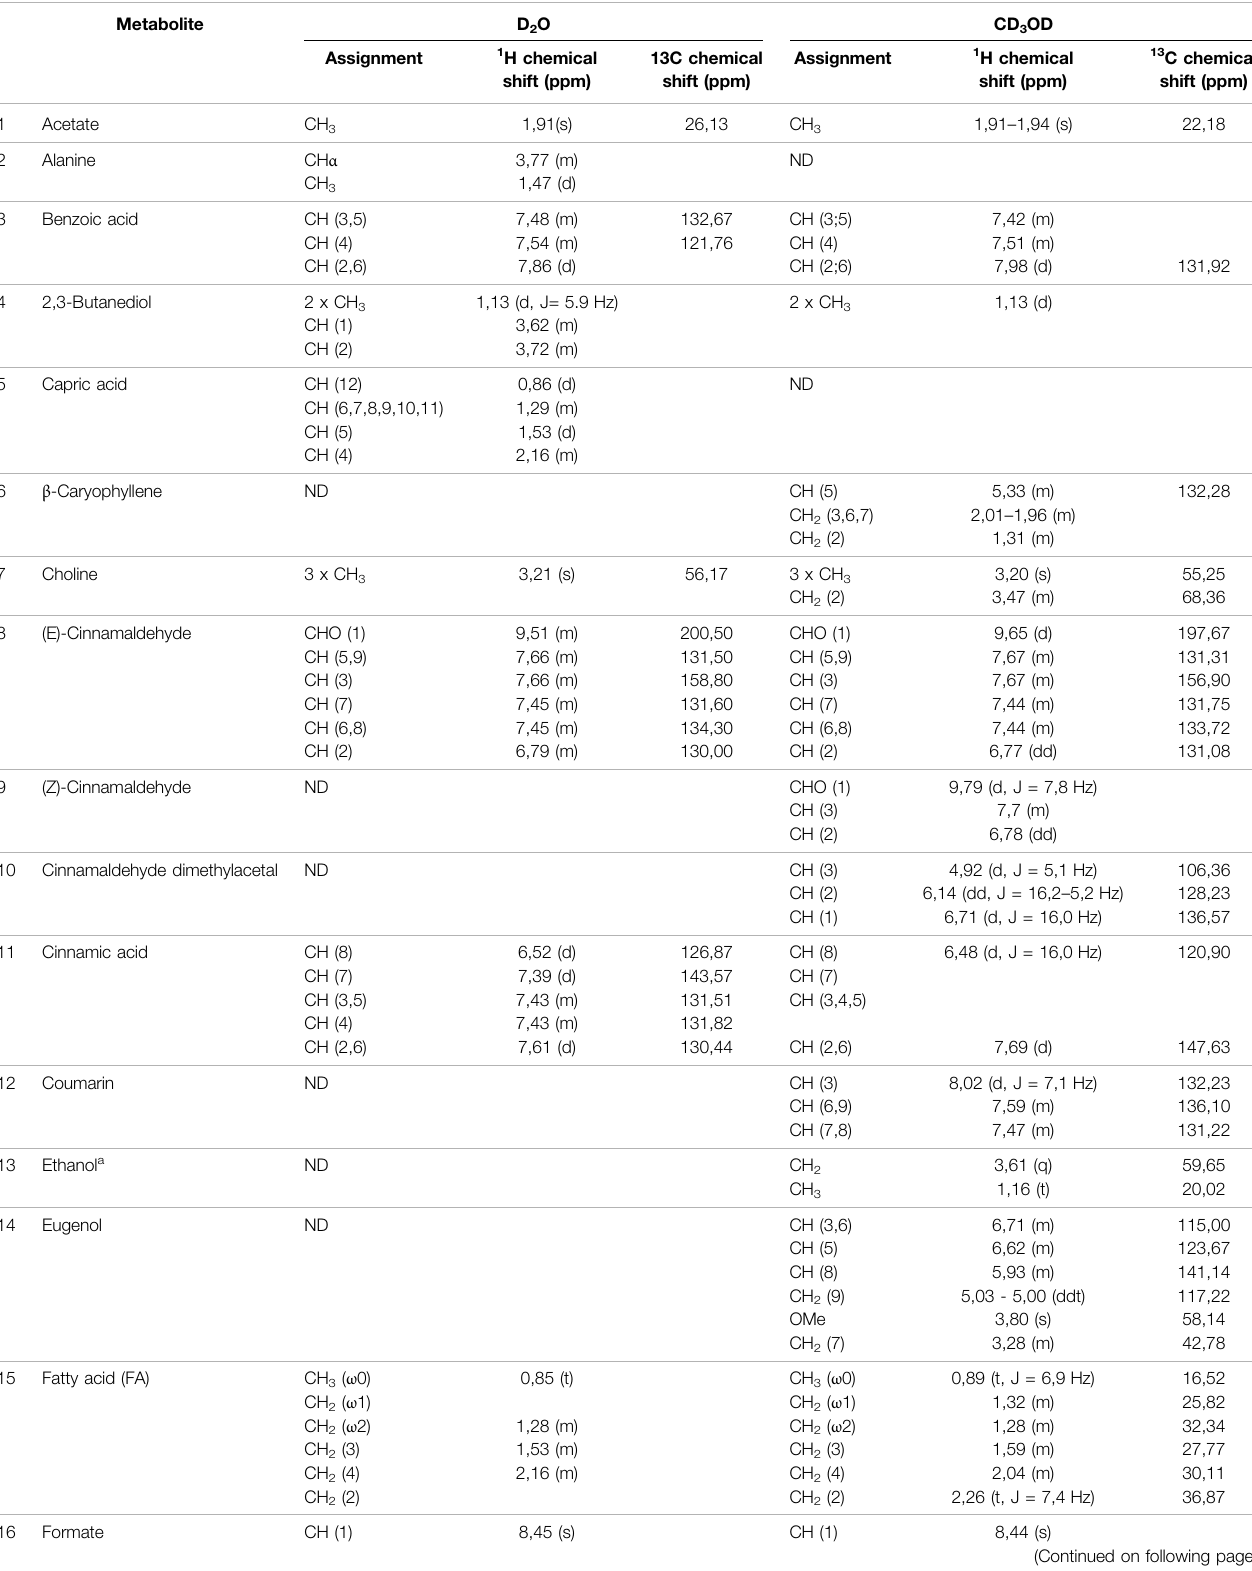
TABLE 1 | Assignments of 1 H and13C chemical shifts of the resonances of metabolites contained in cinnamon extracts as found in 1 H-NMR, 1 H, 1 H-TOCSY, and 1 H, 13 C-HSQC spectra of samples dissolved in D 2 O and CD 3 OD. ND (not detected) indicates that the resonances of the metabolites were not found in the spectrum of the sample. Missing values of chemical shifts are due to overlapped resonances or signals with too low